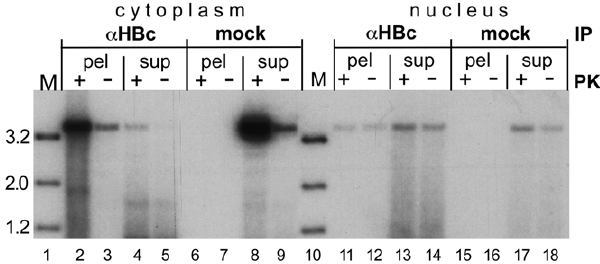
Figure 8. Evidence for a fraction of completely uncoated, largely protein-free nuclear HBV RC-DNA. HepG2 cells were transfected with the vector for surface-deficient HBV. IPs were performed as in Figure 5, except that DNA from both the immunopel- lets (pel) and the supernatants (sup) was analyzed; in addition, the samples were treated, or not treated, with PK prior to DNA extraction as indicated. Note the high proportion of rcDNA in the a HBc supernatant from the nuclear vs. cytoplasmic sample, and the likewise high proportion of rcDNA signals in the nuclear vs. cytoplasmic samples not treated with